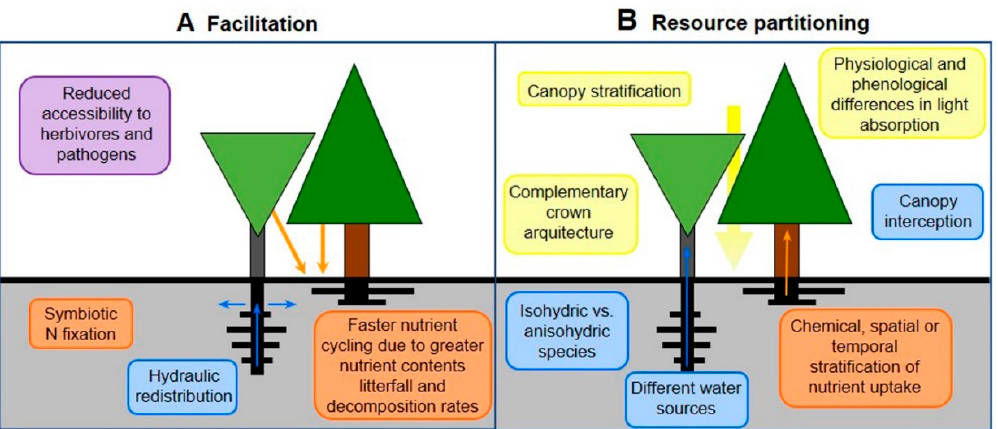
Figure 3. Illustration of underlying mechanisms that may lead to biodiversity effects divided into facilitation ( A ) and resource partitioning ( B ). Different colors represent processes related with nutrients (orange), water (blue), light (yellow), and biological agents (purple).